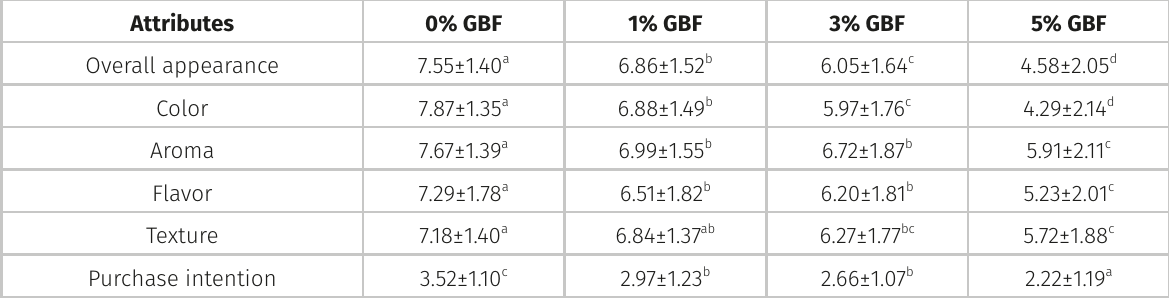
Table IV. Sensorial attributes of guava juice formulations containing 0, 1, 3 and 5% of guava by-product